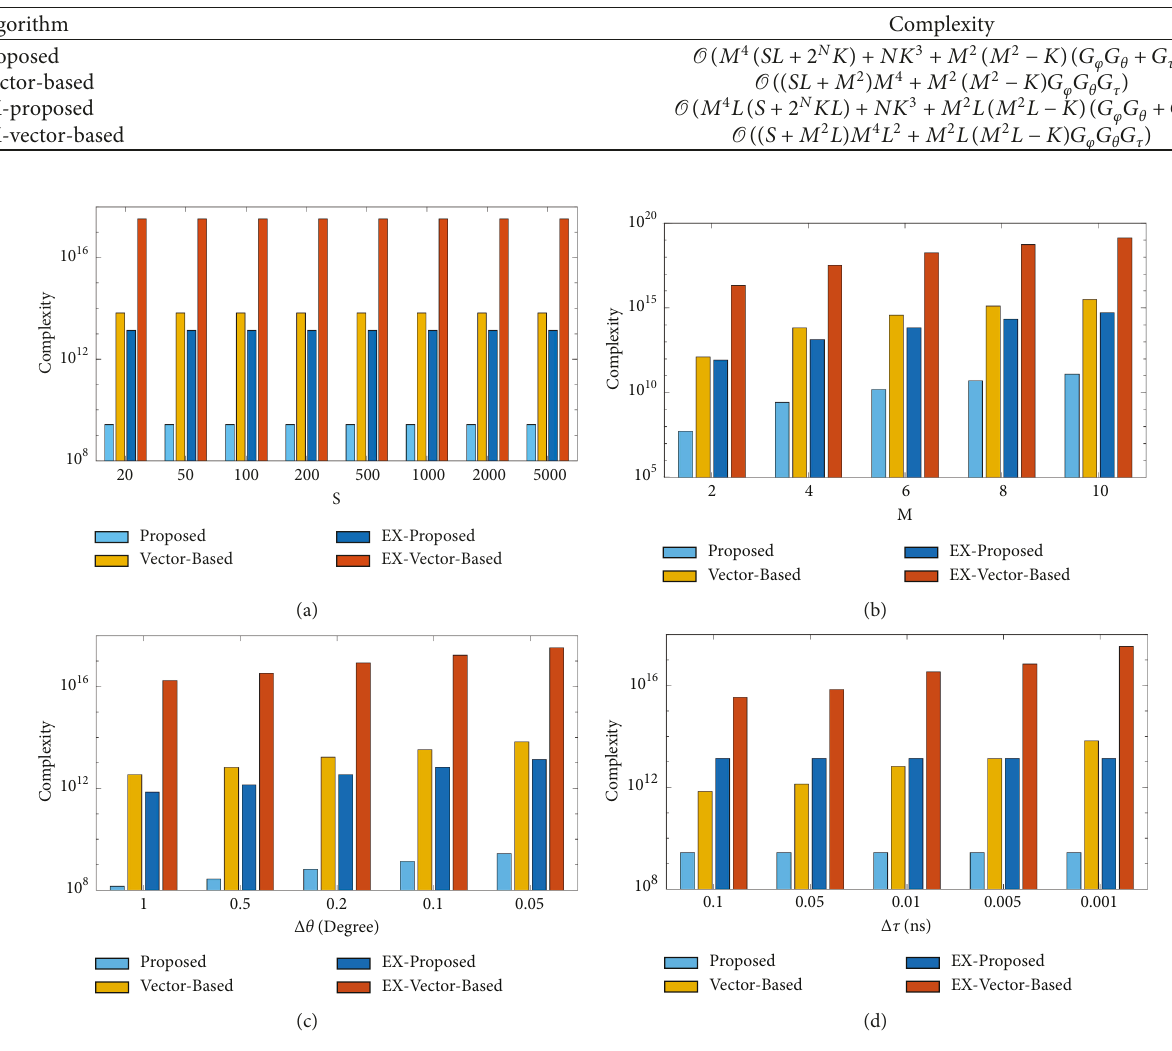
Figure 2: Complexity comparison(a) versus S where M � 4, Δ θ � 0 . 05 ° , and Δ τ � 0 . 001ns(b)versus M where S � 500, Δ θ � 0 . 05 ° , and Δ τ � 0 . 001ns(c)versus Δ θ where M � 4, S � 500, and Δ τ � 0 . 001ns(d)versus Δ τ where M � 4, S � 500, and Δ θ � 0 . 05 °